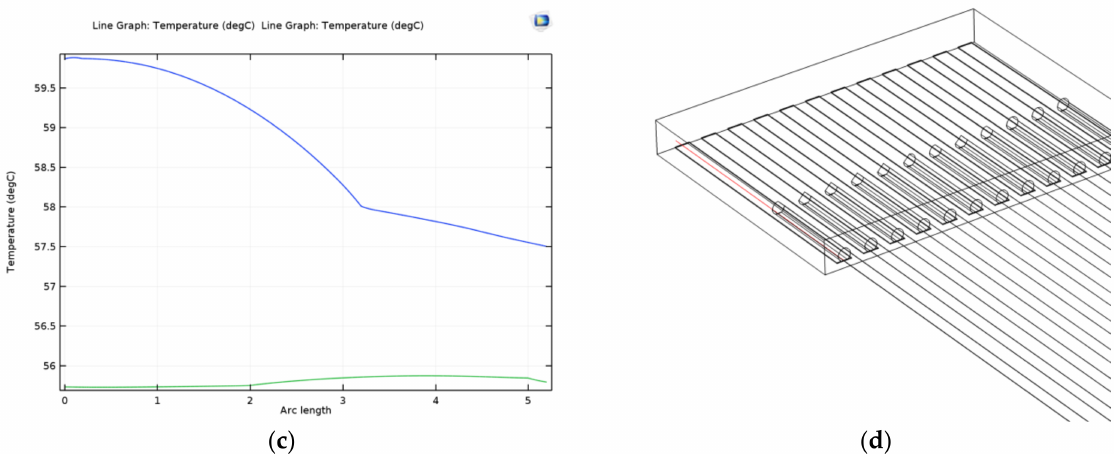
Figure 17. Simulation results of temperature distribution along thermoelectric legs: ( a ) general view of the sensor; ( b ) cross- section of the thermoelectric legs; ( c ) temperature distribution along screen-printed legs inside of left (blue) and right (green) LTCC substrates; ( d ) visualization of the line for blue graph.